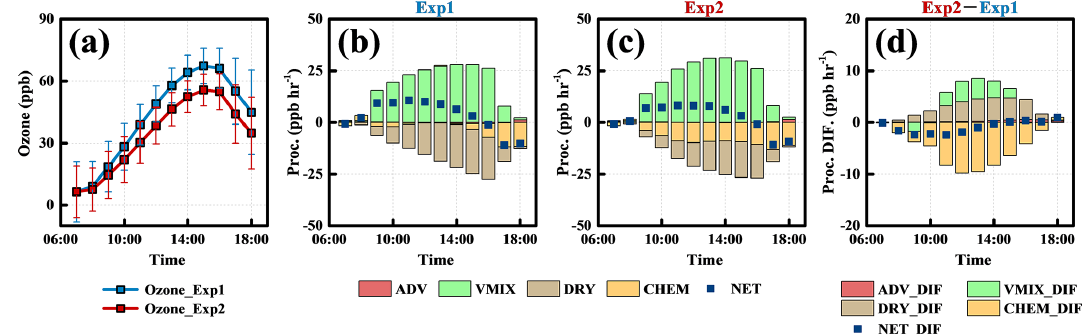
Figure 5. Averaged surface ozone concentrations and process analysis results of the four cities in the daytime. Mean ozone concentrations from Exp1 and Exp2 are presented in (a) ; the corresponding hourly process contributions from Exp1 and Exp2 are presented in (b) and (c) ; the changes in each process induced by aerosol (Exp2–Exp1) are presented in (d) . CHEM = chemistry; VMIX = vertical mixing; DRY = dry deposition; ADV = advection; NET = CHEM + VMIX + DRY + ADV. Changes in each process contribution and NET contribution are denoted by CHEM_DIF, VMIX + DRY_DIF, ADV_DIF and NET_DIF, respectively. Time is local